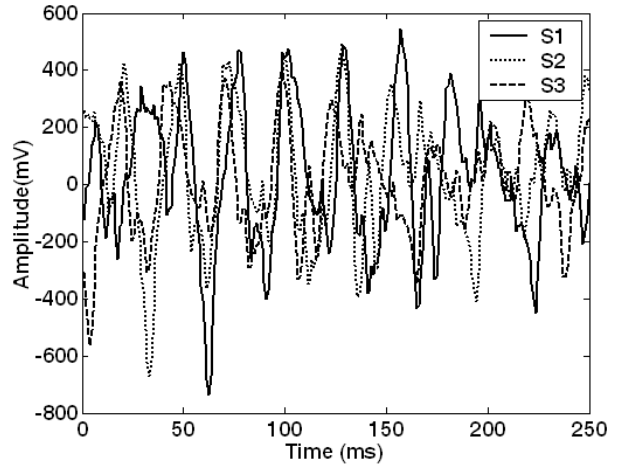
Figure 11. Acoustic signatures measured by microphones at s1, s2 and s3.